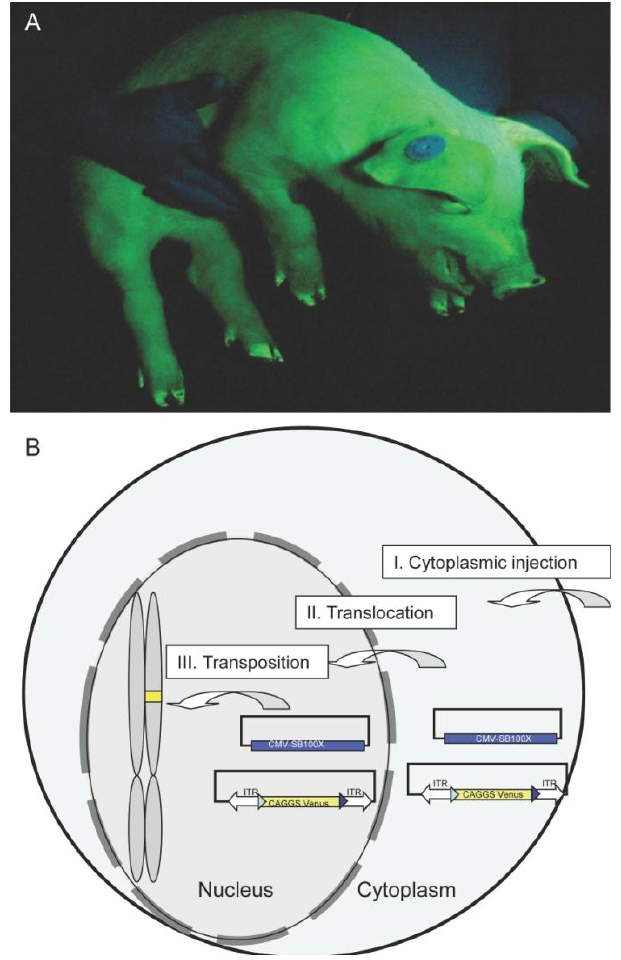
Figure 2. Transposon transgenic pig expressing Venus reporter. (A) Boar #505 under specific Venus excitation at the age of four weeks, Venus fluorescence is indicated by green color. Note the blue appearance of the hands holding the pig is due to reflected and scattered excitation light; (B) Scheme of CPI injection. After injection of the plasmid solution into the cytoplasm (I.), the plasmids translocate into the nucleus (II.). Expression of the SB100× helper plasmid results in the production of active SB protein and specific transposition of the transposon (without plasmid backbone) into the genome